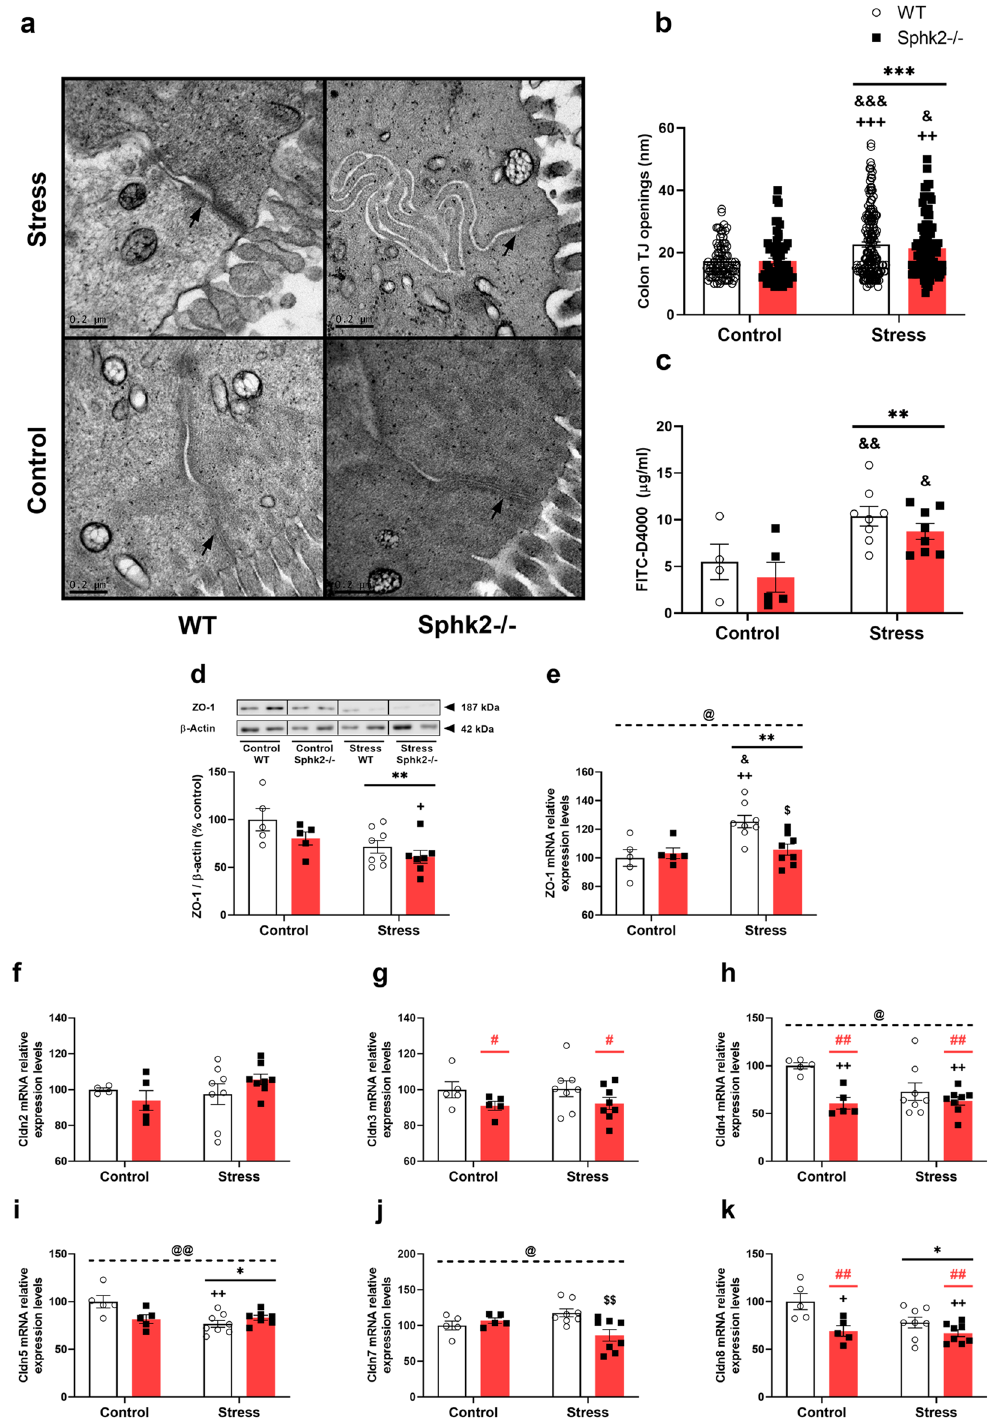
Figure 6. Intestinal permeability analyses and expression levels of structural proteins in the colon of WT and Sphk2−/− mice after sub-chronic stress exposure. Representative transmission electron micrographs of colonic tight junctions (TJs) in epithelial cells of each group ( a ), quantification of TJs ( b ), and FITC-D4000 detected in plasma ( c ), ZO-1 protein expression ( d ), ZO-1 mRNA levels ( e ), Cldn2 mRNA levels ( f ), Cldn3 mRNA levels ( g ), Cldn4 mRNA levels ( h ), Cldn5 mRNA levels ( i ), Cldn7 mRNA levels ( j ), Cldn8 mRNA levels ( k ). For b, data are means ± SEM of 66–168 TJs per group. Arrows indicate TJ ultrastructure. For c-k, data are means ± SEM of 5–8 mice per group. The densitometric data of the respective bands of interest are normalized by β-actin (lower band). Blots were cropped (black lines) to improve the clarity and conciseness of the presentation. Two-way ANOVA considering stress (S) and Sphk2−/− as independent variables followed by Tukey’s post hoc; *S p < 0.05, **S p < 0.01, ***S p < 0.001; #Sphk2−/− p < 0.05, ##Sphk2−/− p < 0.01; @ (interaction) p < 0.05, @@ p < 0.01; + p < 0.05, ++ p < 0.01, +++ p < 0.001 vs Control WT; & p < 0.05, && p < 0.01, &&& p < 0.001 vs Control Sphk2−/−; $ p < 0.05, $$ p < 0.01 vs Stress WT. Sphk2: sphingosine kinase 2; WT: wild-type; Sphk2−/−: Sphk2 knockout; TJ: tight junction; FITC-D4000: FITC- dextran average molecular weight 4000; ZO-1: zonula occludens-1; Cldn: